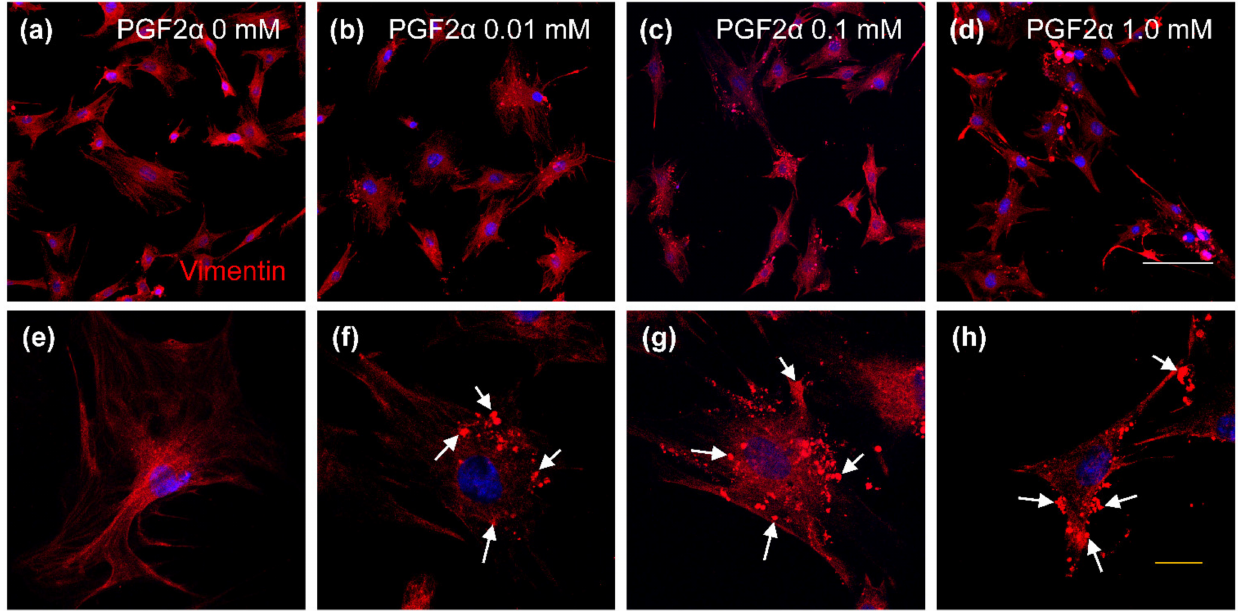
Figure 5. Confocal laser scanning microscope image of vimentin protein in prostaglandin F2 alpha (PGF2 α )-induced bovine luteal thecal cells (LTCs). The LTCs were incubated in culture media supplemented 0 mM ( a , e ), 0.01 mM ( b , f ), 0.1 mM ( c , g ), and 1.0 mM ( d , h ) PGF2 α . Green: vimentin protein, blue: nucleus, white arrows: damaged vimentin, white line: 50 µ m, yellow line: 20 µ